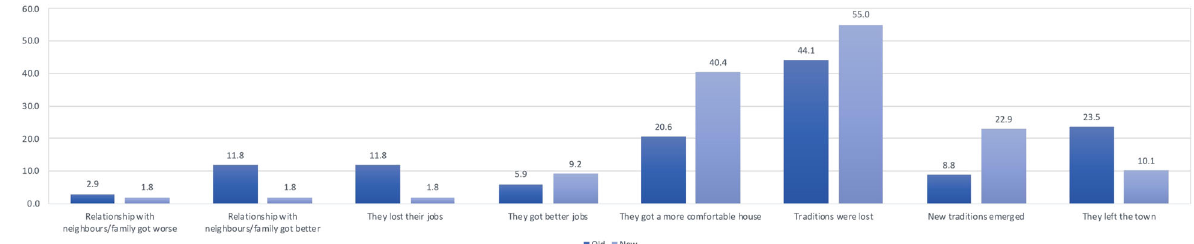
Fig. 5 Local community. How did the move affect your family? Note: The sum of the percentages is not equal to 100% due to the fact that each person was able to respond to several options.